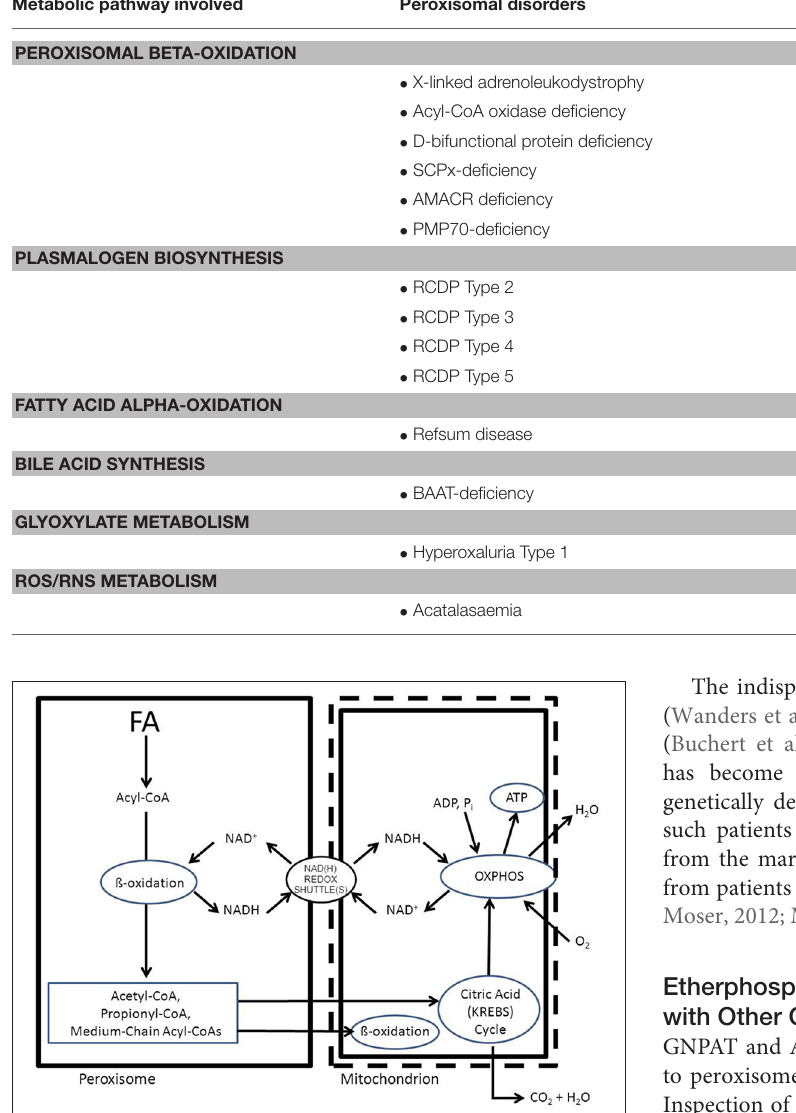
TABLE 1 | The single peroxisomal enzyme deficiencies and their underlying enzyme and gene defects. Metabolic pathway involved